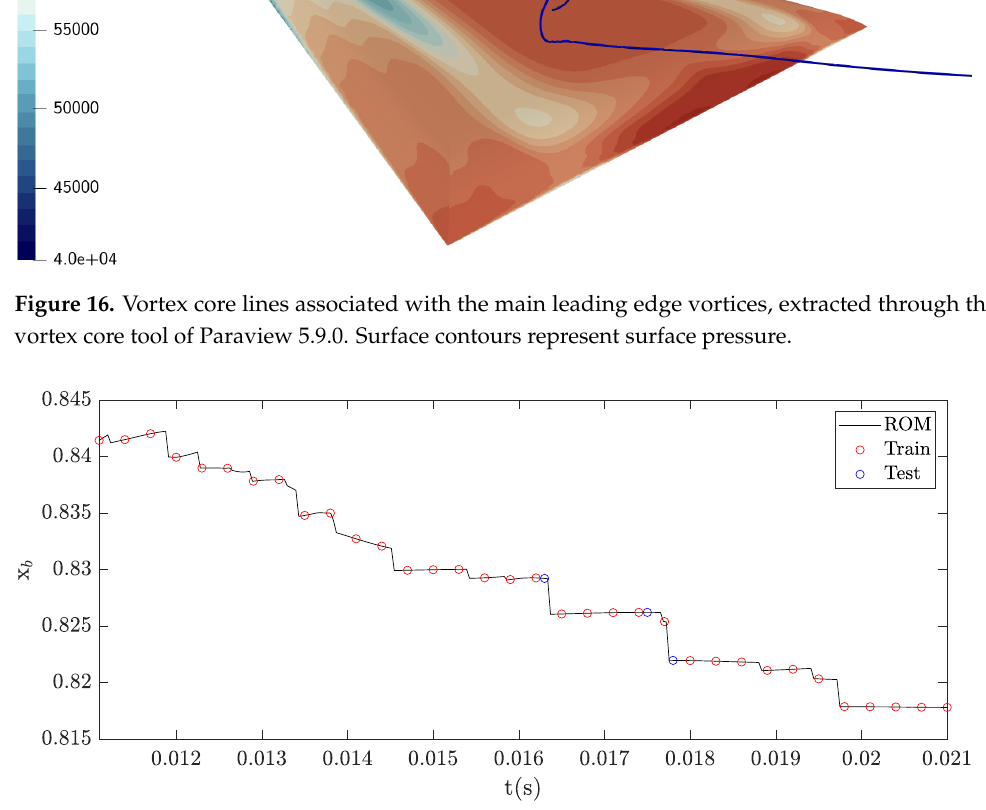
Figure 17. Displacement of vortex breakdown station within the investigated time window. The continuous line represents the ROM; the red circles are the training snapshots; the blue circles represent the test